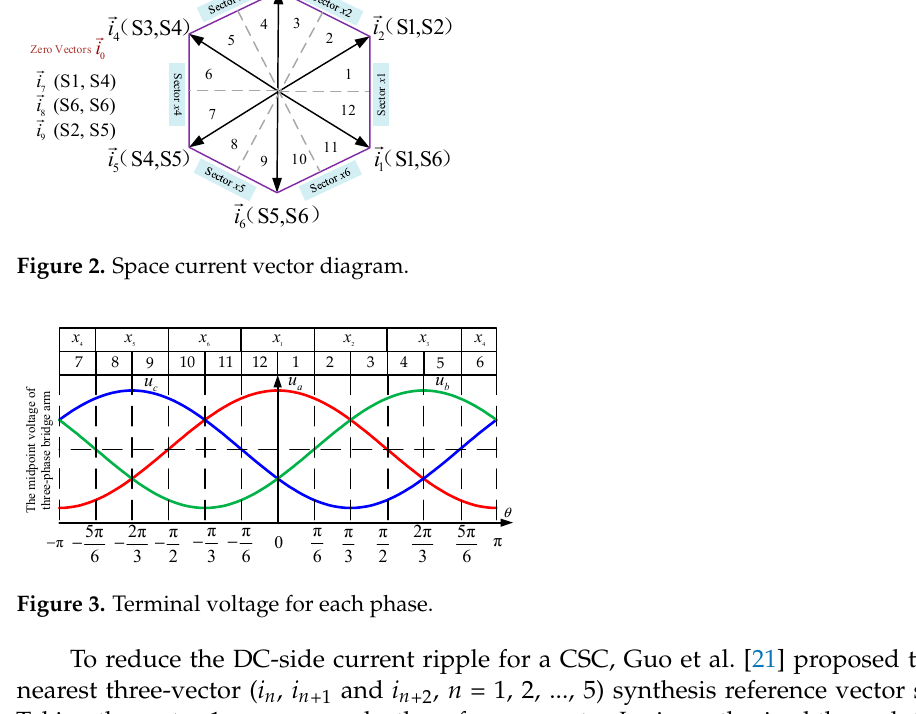
where θ denotes the reference vector angle and (0, / 6) ∈θ π , T s denotes the switching pe- riod, m denotes the modulation index and i dc denotes the DC-side inductor current. In the even (2, 4, 6, 8, 10, 12) sectors, the dwell times for three vectors are: